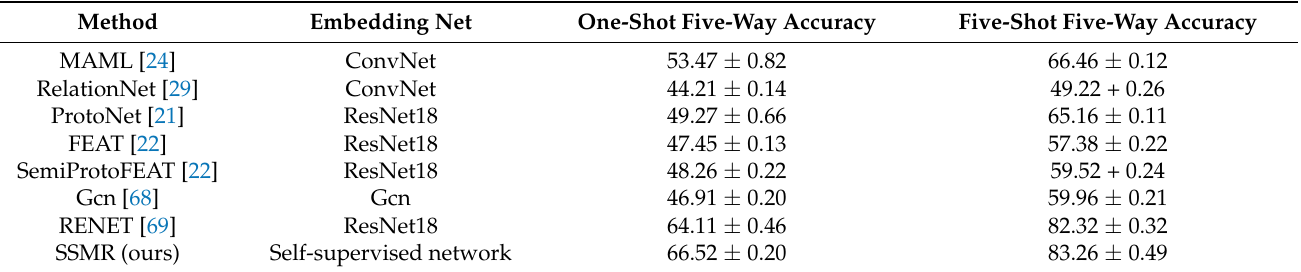
Table 3. One-shot five-way and five-shot five-way task accuracy (%) comparison, with 95%